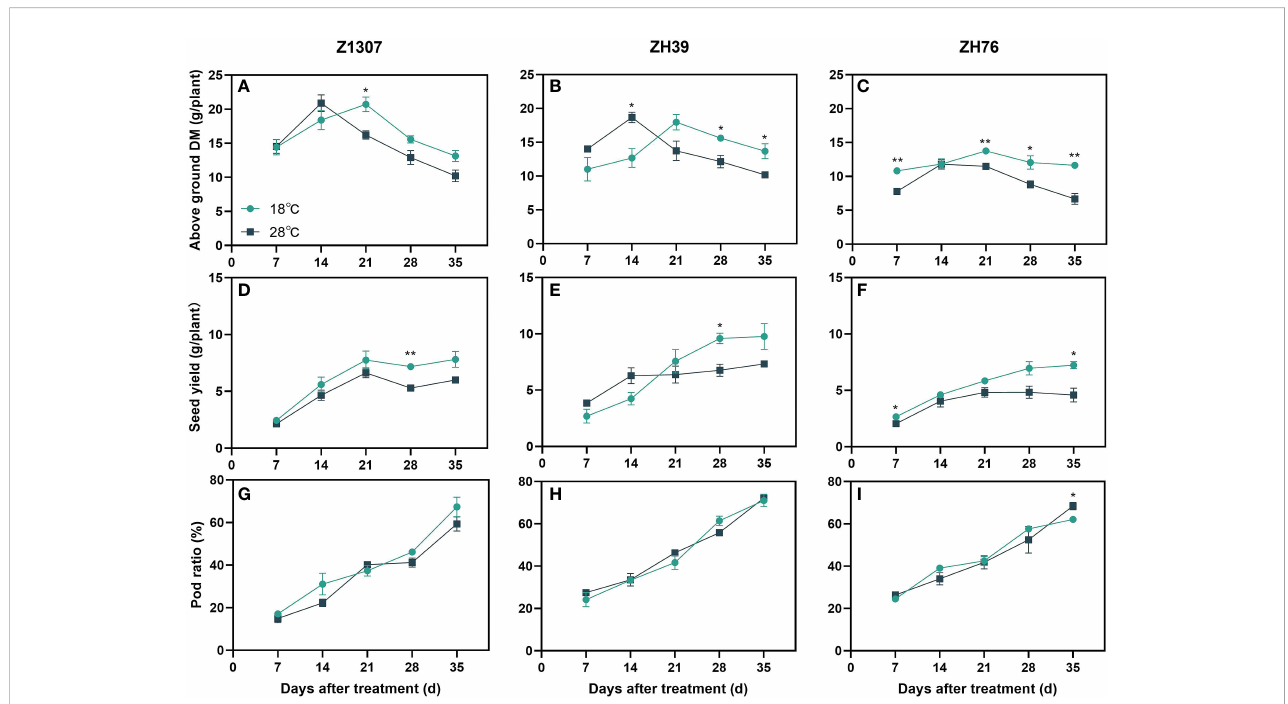
FIGURE 2 Effects of high night temperature on total dry matter(DM), seed yield and pod ratio. The light blue /dark blue line indicates the 18 ℃ /28 ℃ treatment. DM means dry matter. The broken lines respect the dynamic changes of soybean above ground DM (A-C) , seed yield (D-F) and pod ratio (G-I) with the days of different high night temperature treatments for the three varieties of Z1307, ZH39 and ZH76. Values shown are means ± SE from three biological replicates. (*, P < 0.05; **, P <